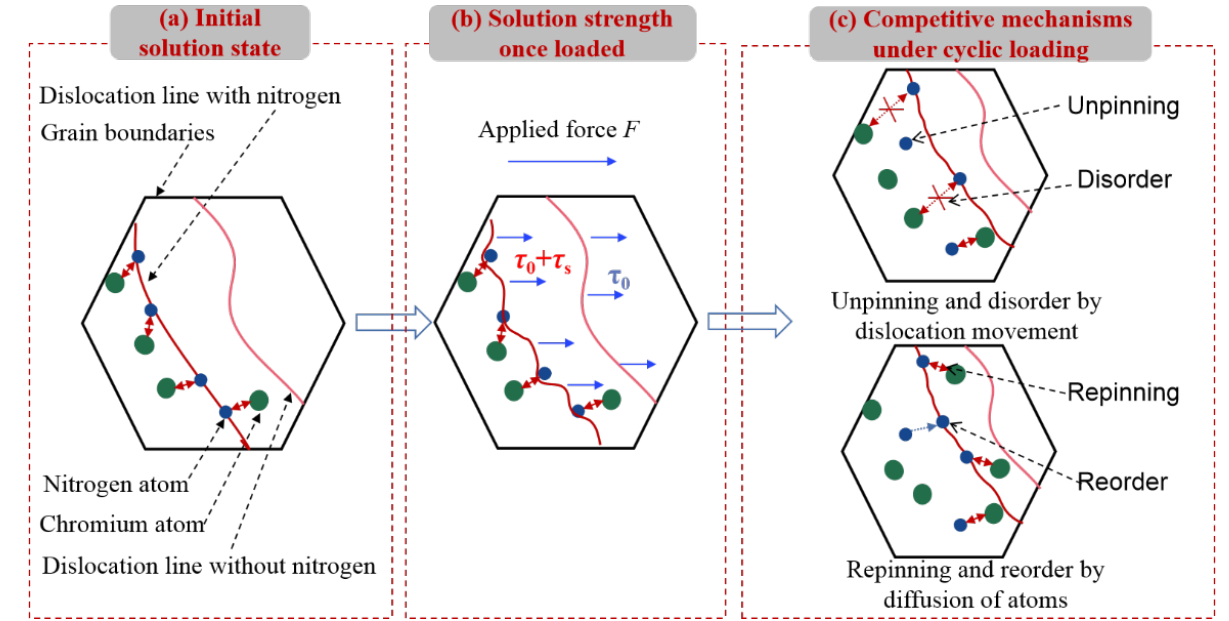
Figure 13. Evolution of interaction between nitrogen atoms and dislocation movements under cyclic